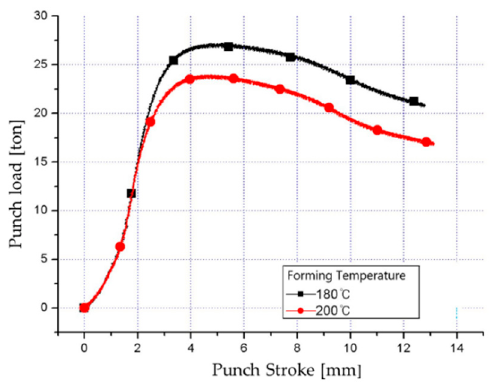
Figure 6. Effects of temperature on the punch loads. (Punch speed = 2 mm/s, FER = 2.25, BER = 7.75).